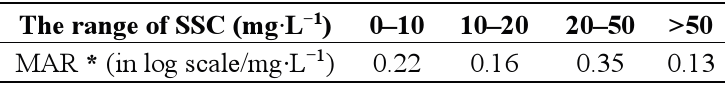
Table 5. The statistics of retrieval accuracy (in logarithm space) of the semi-analytical model for different SSC ranges corresponding to 90 samples in the study area.